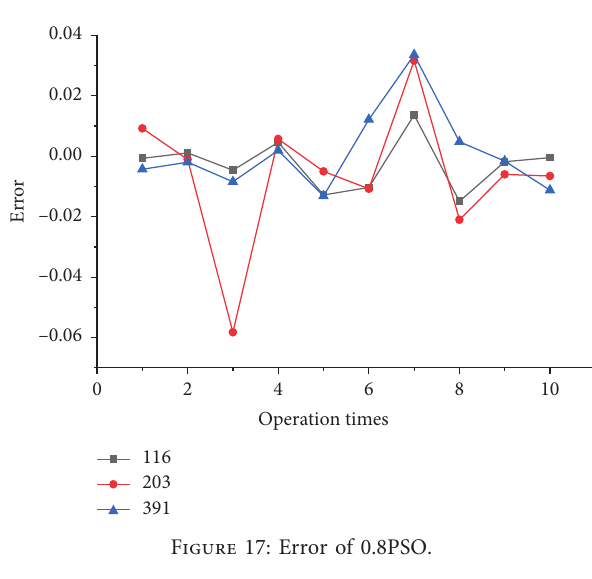
Figure 17: Error of 0.8PSO.